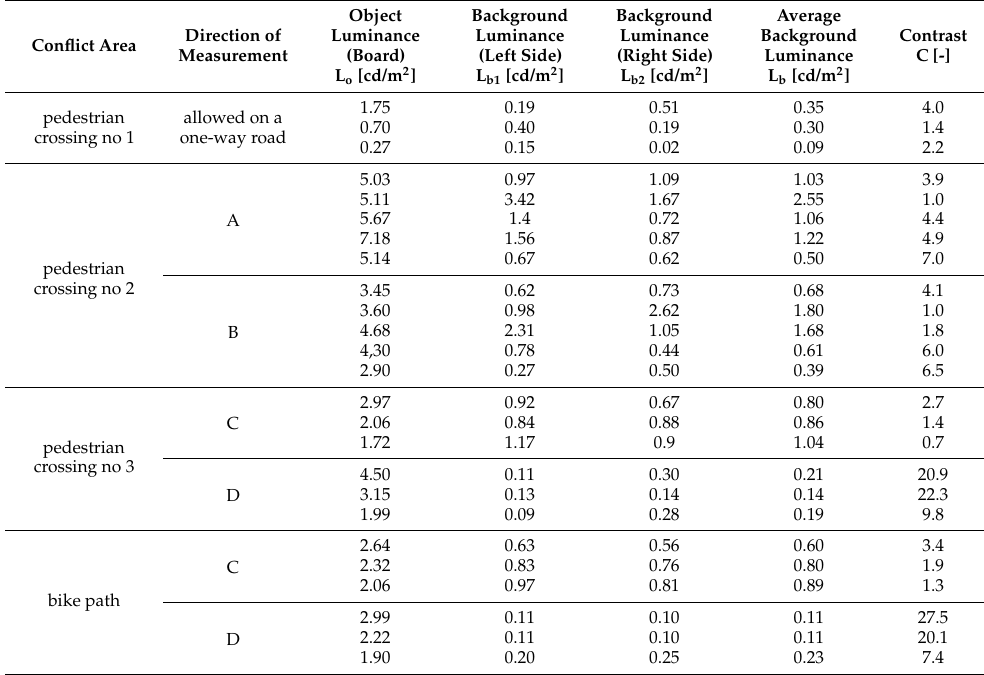
Table A6. Measurement results for luminance contrast at the pedestrian